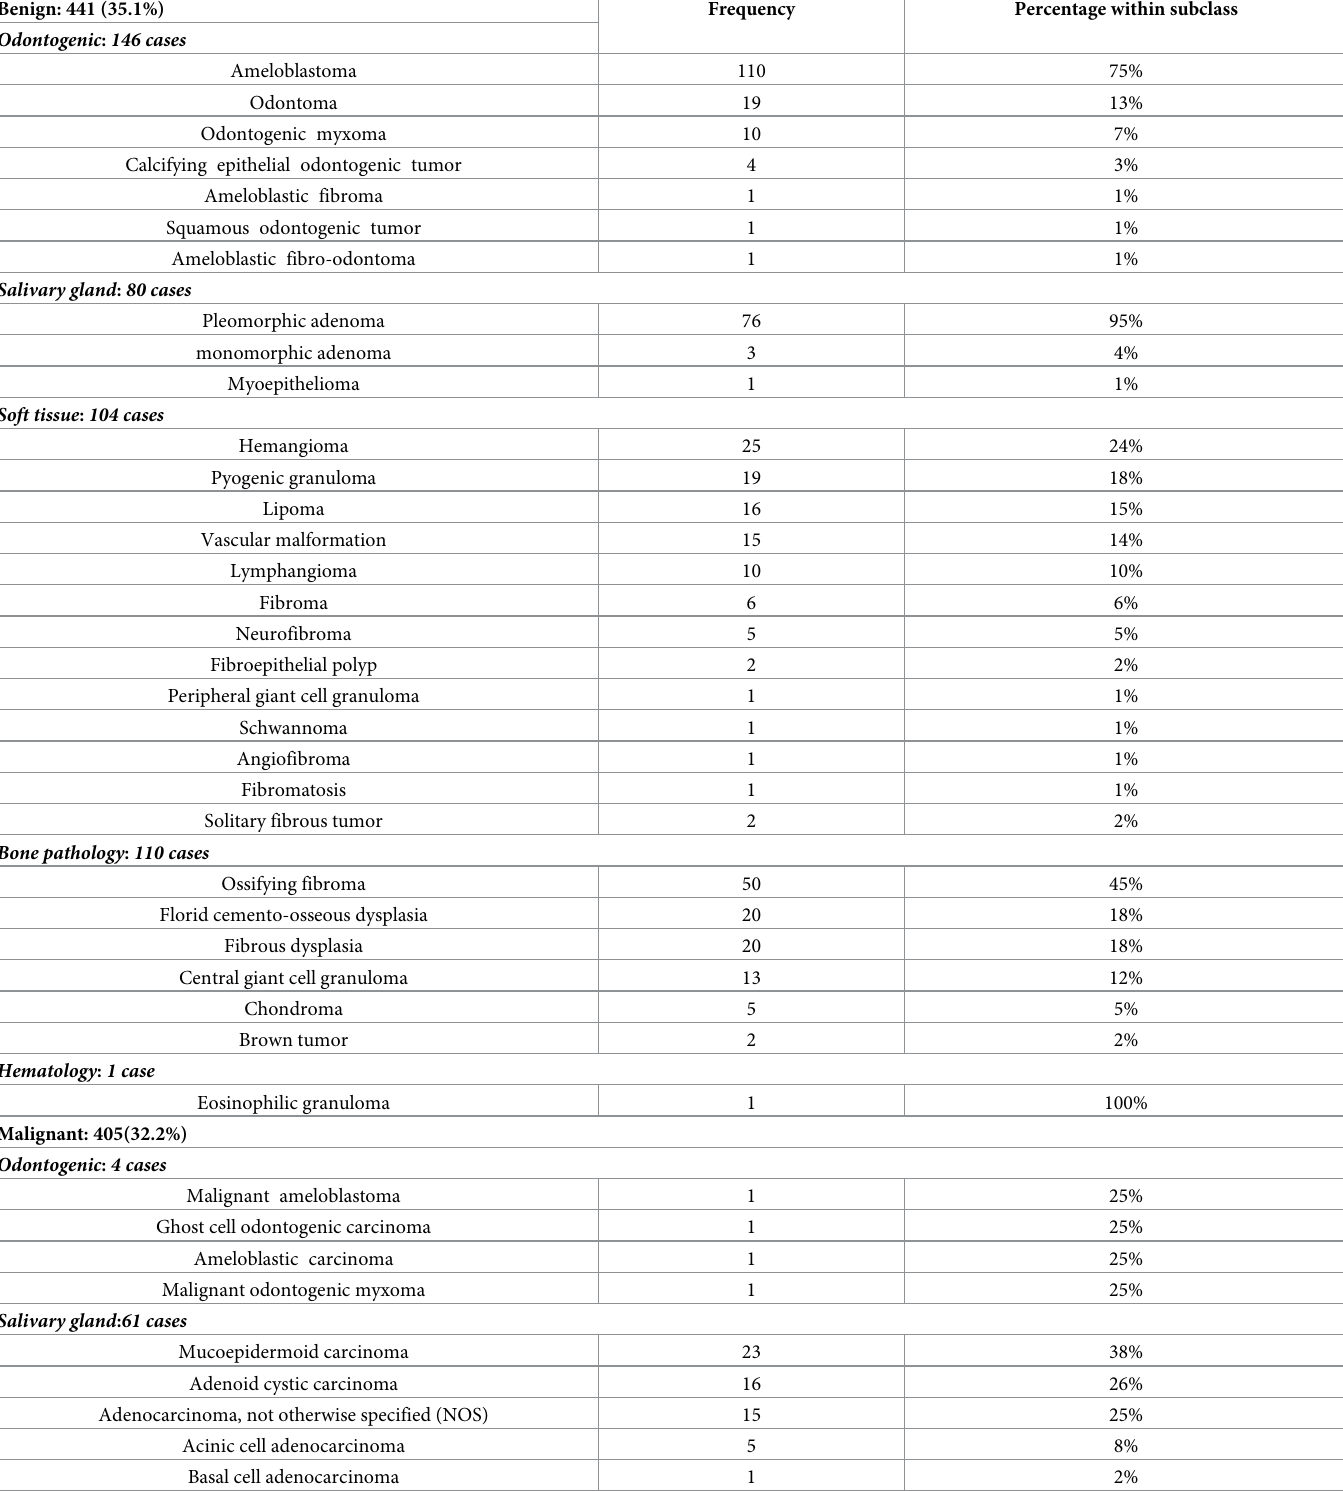
Table 4. Frequency of 1256 pathological diseases presented as class, subclass, and individual diagnosis. Benign: 441